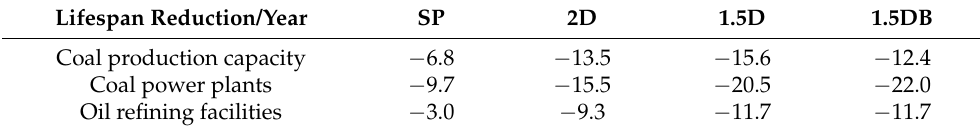
Table 6. Average lifespan reduction on fossil energy